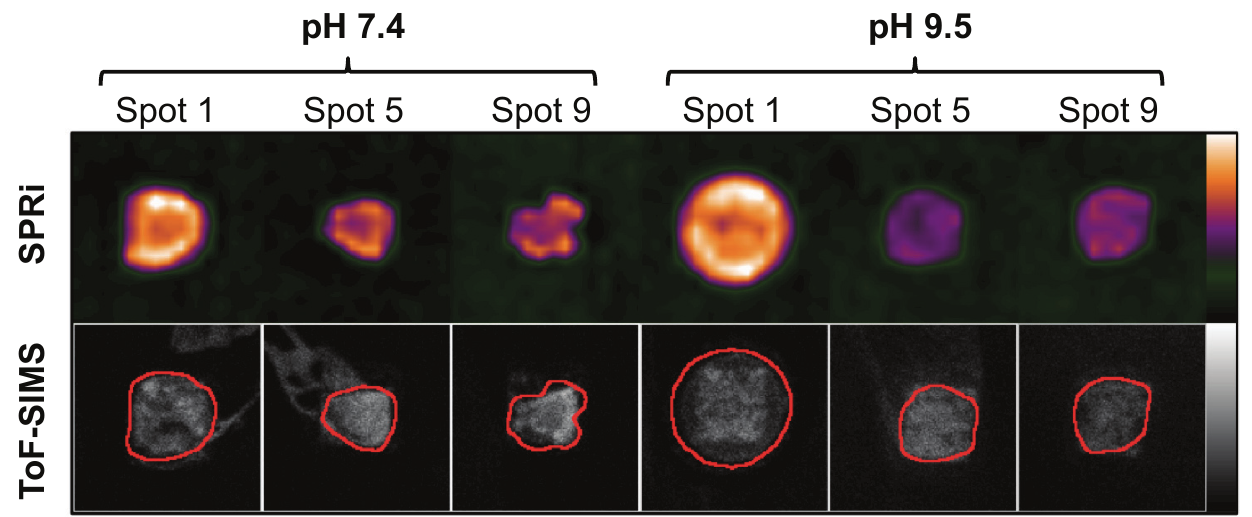
Figure 5. SPRi and ToF-SIMS analyses correlate glycan bioactivity and distribution between replicate spots on identical arrays, despite variability in spot morphology due to printing conditions. These results suggest that ToF-SIMS can be used to characterize printed glycan arrays and predict their